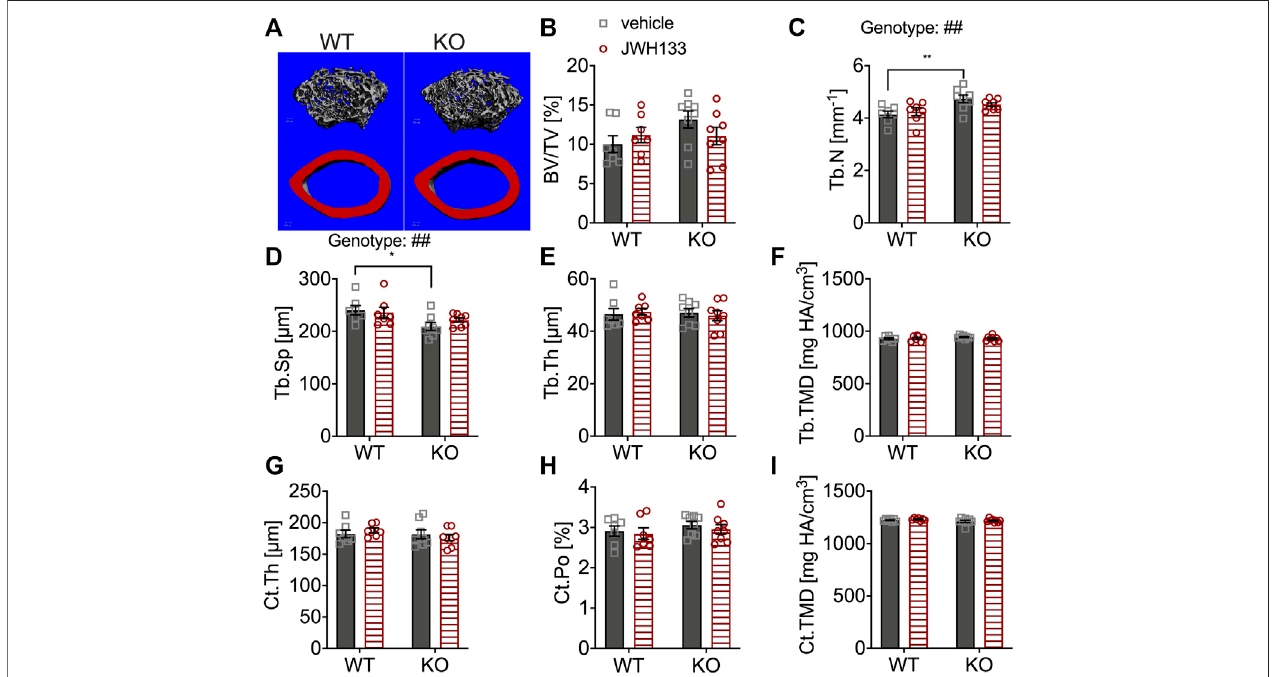
FIGURE2| μ CToffemurs showed theincreased trabecular number and correspondingly reduced spacing inp62 KO mice. (A) Trabecular (grey) and cortical (red) bonestructureofthefemurofWTandp62KOmice. (B) Bonevolumepertotalbonevolume(BV/TV)wassimilarbetweenWTandp62KOmiceandshowednoeffectof treatment. (C) Trabecular number (Tb.N) was signi fi cantly increased in vehicle-treated p62 KO mice compared to vehicle-treated WT mice. No effect of genotype was observed after treatment. (D) Trabecular spacing (Tb.Sp) was reduced in vehicle-treated p62 KO mice compared to WT mice. (E) Trabecular thickness